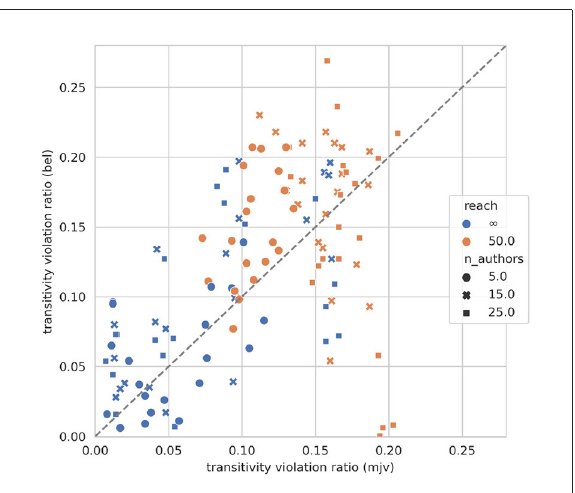
FIGURE2 Initial transitivity violation according to degrees of belief ( y -axis) and sentence-wise vote ratios ( x -axis).